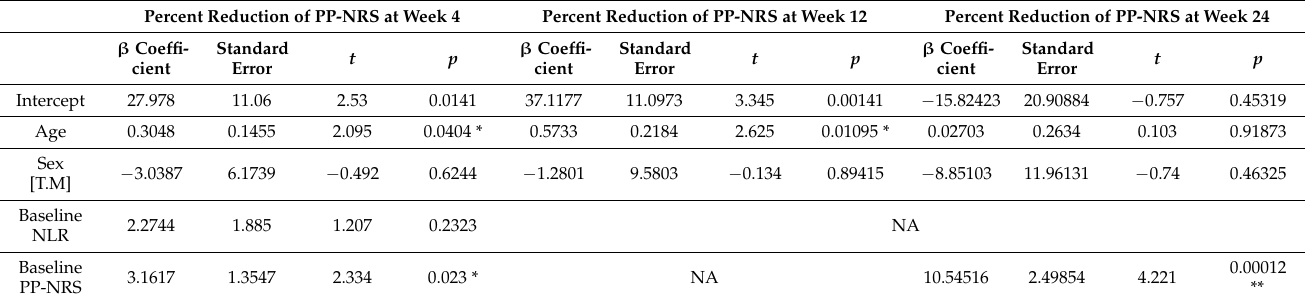
Table 7. The predictive factors for the percent reduction of the peak pruritus-numerical rating scale (PP-NRS) at weeks 4, 12, or 24 of upadacitinib treatment assessed by linear multivariate regression analysis in patients with atopic dermatitis ( n =